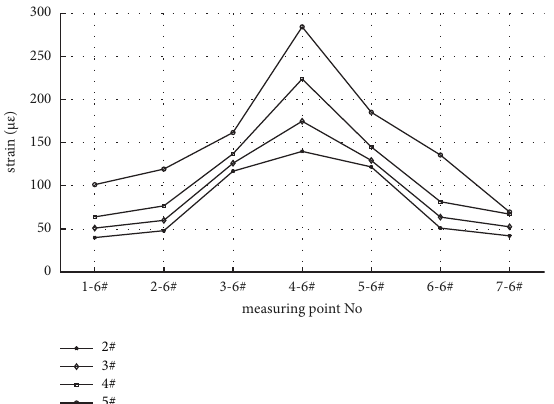
Figure 13: Strain distribution diagram of each section (tensile side).